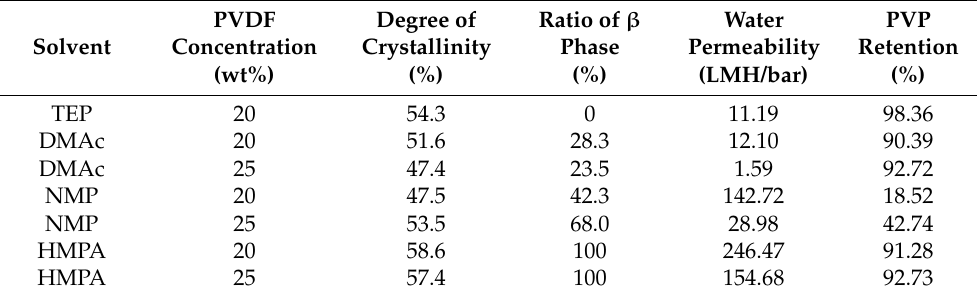
Table 3. Properties and performance of membranes prepared with NIPS using various